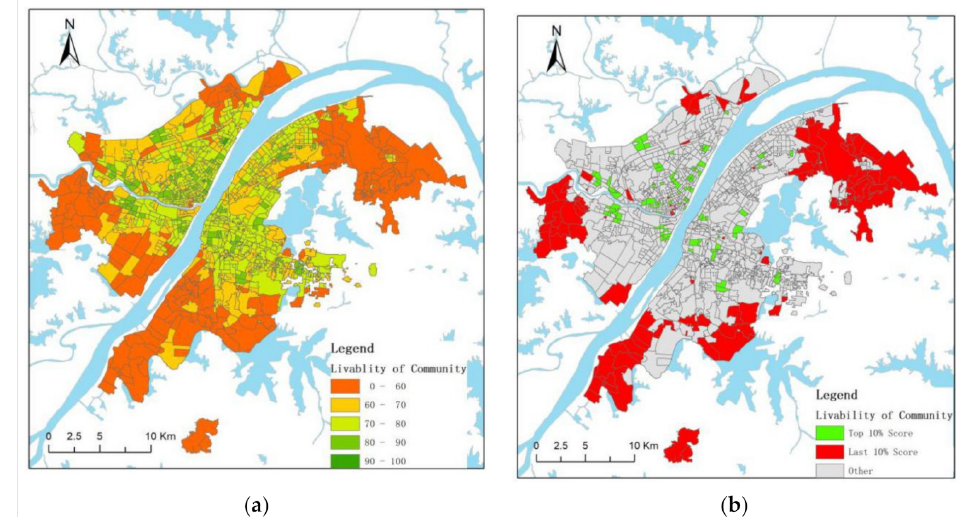
Figure 7. The spatial distribution of evaluation of community livability: ( a ) Distribution of community livability score; ( b ) High-score and low-score distributions. In ( a ), the red community represents the lower livable score community and the green community represents the high livable score community; ( b ) shows 10% communities of high scores in green and 10% communities of low scores in red.